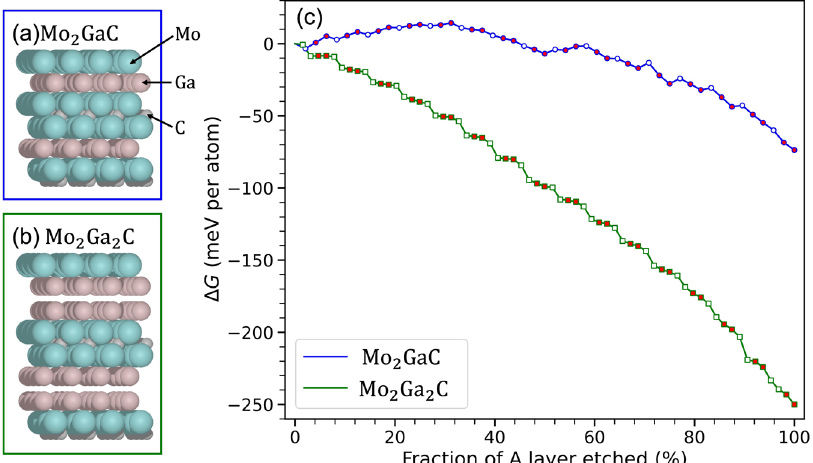
Fig. 3 Sequential selective etching of the A element from molybdenum gallium carbides. Stepwise selective etching of Ga elements from Mo 2 GaC and Mo 2 Ga 2 C resulting in the removal of one of the two Ga (single or double) layers in the unit cells of the respective materials. a , b Cross-sections of the two materials, show that Mo 2 GaC has a single Ga layer while Mo 2 Ga 2 C has a double Ga layer. c The free energy as a function of removing a Ga single or double layer. An empty circle/square denotes the removal of a Ga atom, while a circle/square fi lled with red indicates the binding of oxygen on the emerging MXene surface. Calculated for pH = 0 and an ion concentration of 10 − 3 mol dm − 3